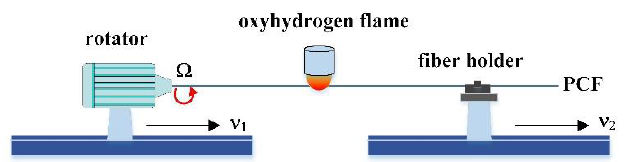
Figure 4. Schematic diagram of twisted photonic crystal fibers (PCF) by use of an oxyhydrogen flame.